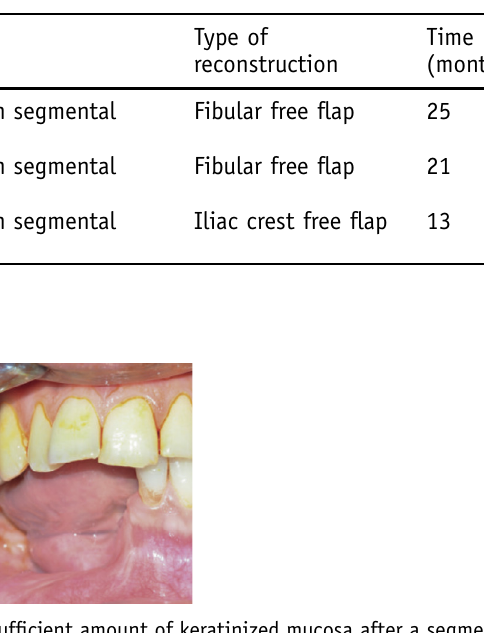
Table I. Description of the population.